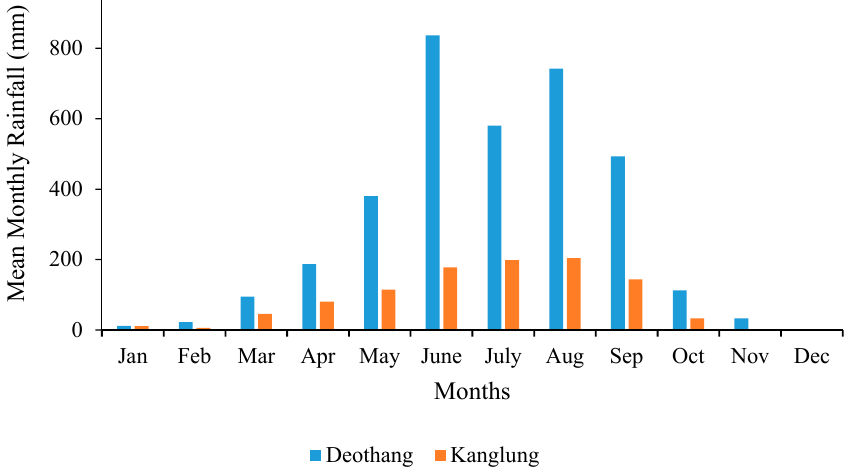
Figure 4. Average monthly rainfall in the study region for both rain gauges (2014–2018).